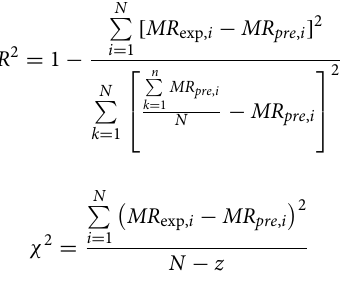
curve fitting. This software has linear and nonlinear regression models and various interpolation methods. In order to select the suitable drying kinetics descriptor, the statistical parameters of R 2 , RMSE and χ 2 were used.